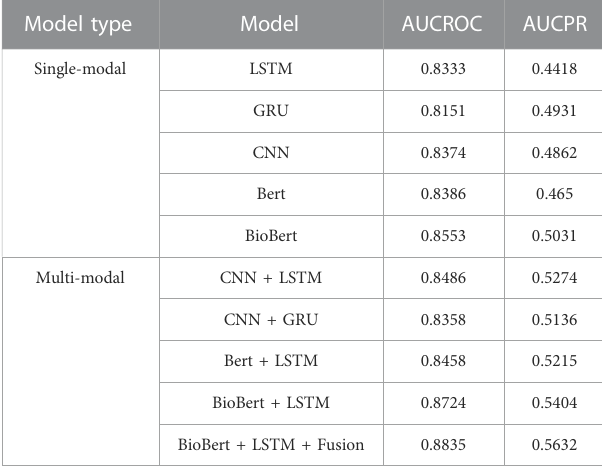
TABLE 1 Performance comparison on MIMIC-III